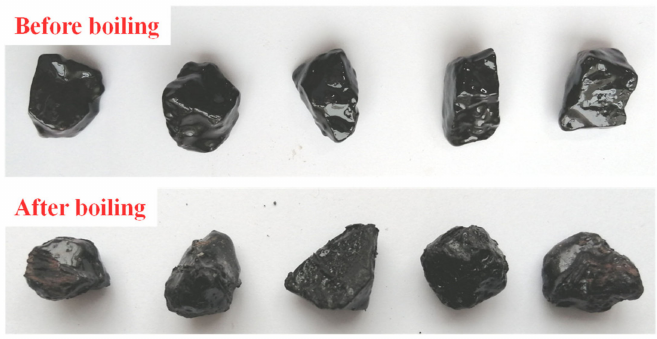
Figure 4. Samples before and after boiling